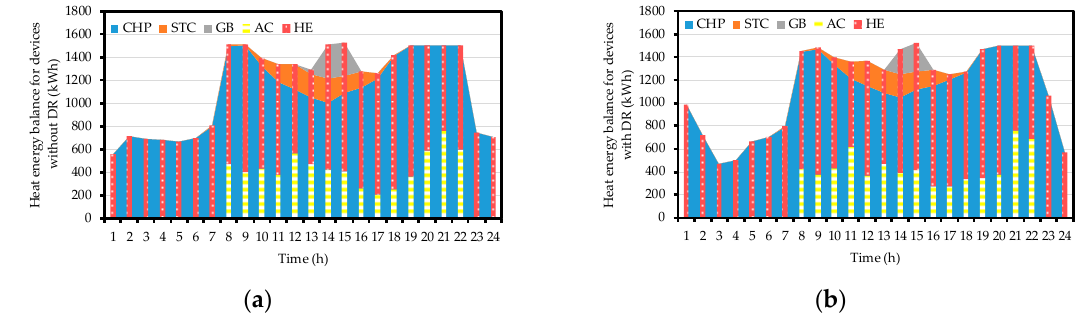
Figure 11. Heat balance for each device: ( a ) without DR; ( b ) with DR.